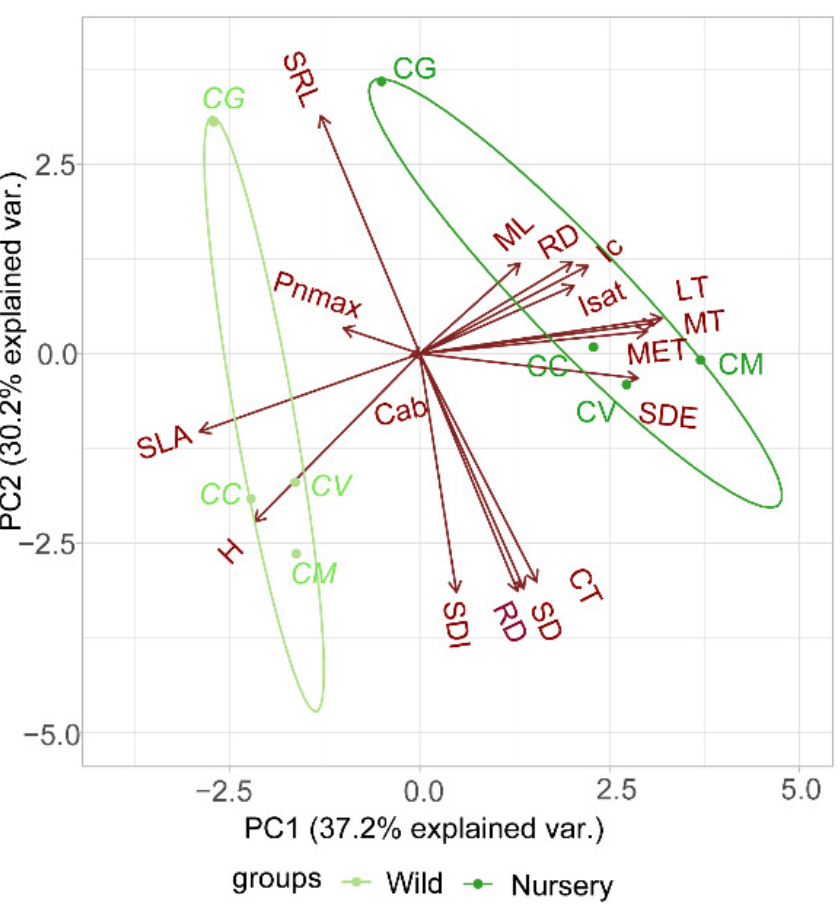
Figure 6. Principal component analysis (PCA) of functional traits of four wild and transplanted Cypripedium species. CC, CG, CM and CV represent C. calceolus , C. guttatum , C. macranthos and C. × ventricosum , respectively. H: seedling height; SDI: stem diameter; LT: leaf thickness; MT: mesophyll thickness; MET: mesophyll cell thickness per layer; ML: mesophyll cell layer; RD: root diameter; CT: cortex thickness; SD: stele diameter; SLA: specific leaf area; SDE: stomatal density; SRL: specific root length; Cab: ratio of chlorophyll concentration, a to b. Pnmax: maximum photosynthesis rate; Isat: saturation irradiance; Ic: compensation irradiance; Rd: dark respiration rate.